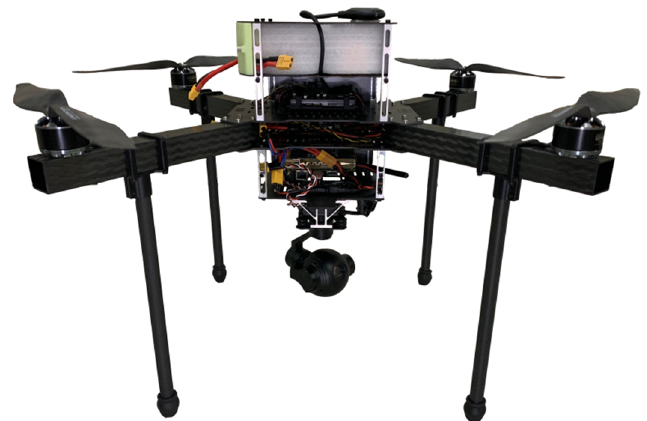
Figure 15a. The IMUs and encoders are consumer sensors at very low prices. The camera with focal lengths ranging from 4.9–49 mm has a maximum resolution of 1920 × 1080 at 60 frames per second (fps). The cost of the gimbaled camera is less than $400, which makes it very attractive considering its great performance. The AS5048A magnetic rotary encoder used in the gimbal system measures the